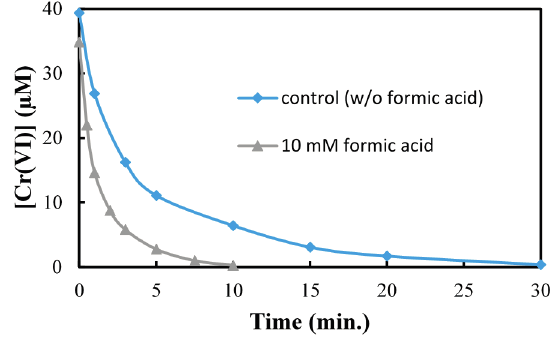
Figure 11. Effect of formic acid as hole scavenger on Cr(VI) reduction. [Cr (VI)] = 40 µM, [HCOOH] = 10 mM, [TiO 2 ] = 0.10 g/L, 350